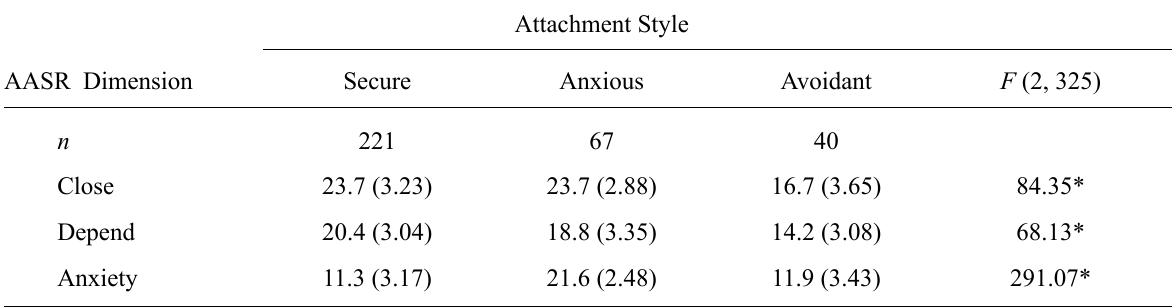
Attachment Style